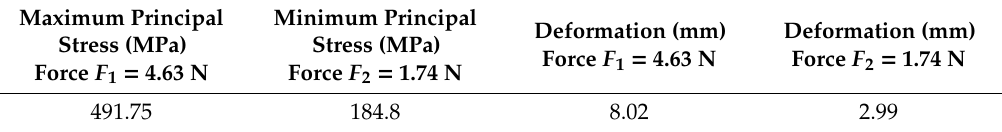
Table 1. Stresses and deformation results from the finite element analysis (FEA).